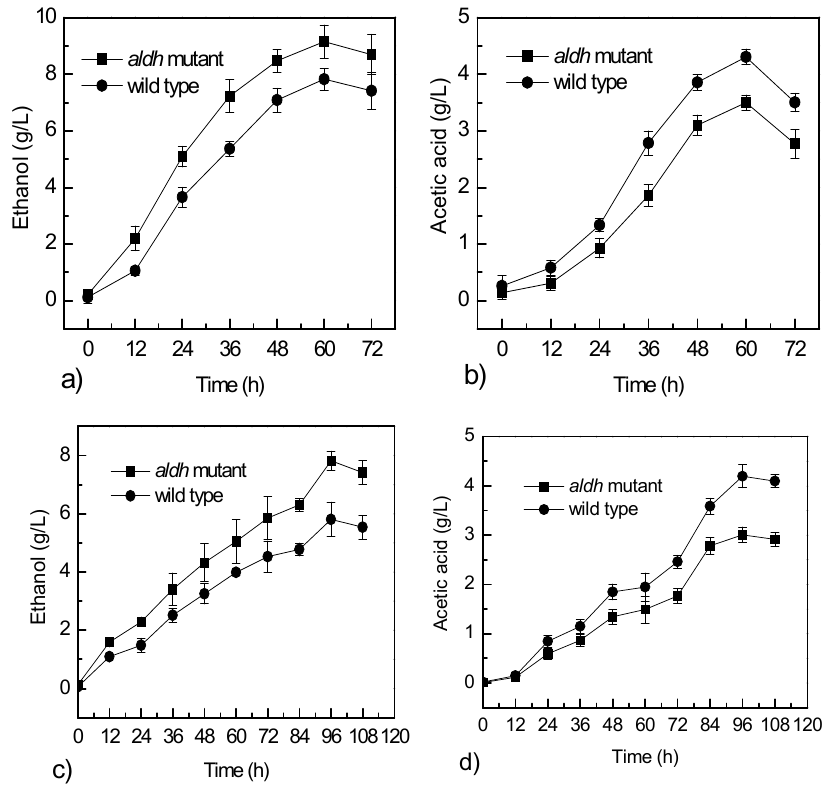
Figure 5. Time course of ethanol and acetic acid concentrations during metabolism of glucose and xylose with mutants. Glucose fermentation ( a , b ); Xylose fermentation ( c , d ). square: mutant strain cs28pCAM-Pstal- ∆ aldh , circle: wild-type strain cs28.